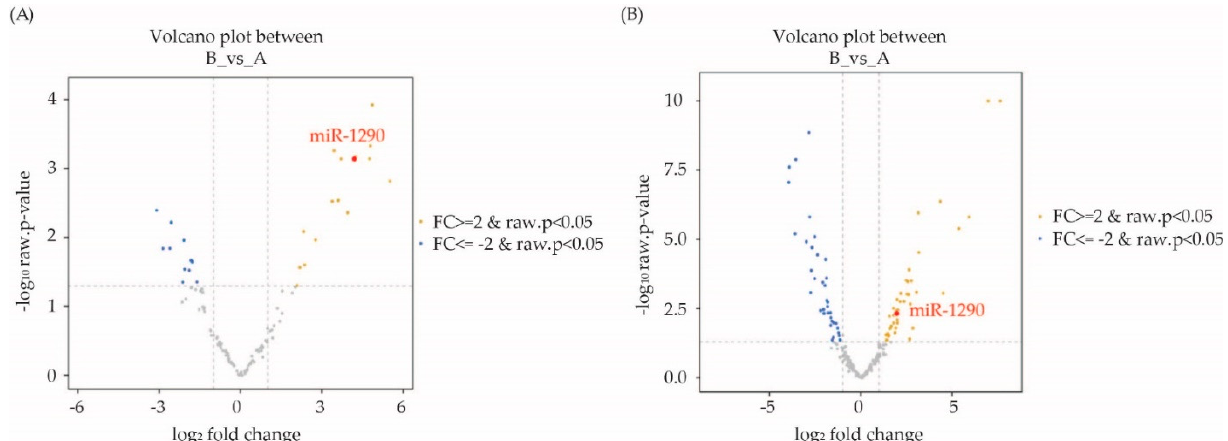
Figure 2. ( A ) Serum. ( B ) FFPE: Volcano plot showing differences in microRNAs (miRNAs) expression between benign and malignant ovarian cancer patients. Yellow dots represent upregulated miRNAs and blue dots represent downregulated miRNAs. Table 3. Fold change of miRNAs expressions in EOC group compared to benign ovarian neoplasm group.